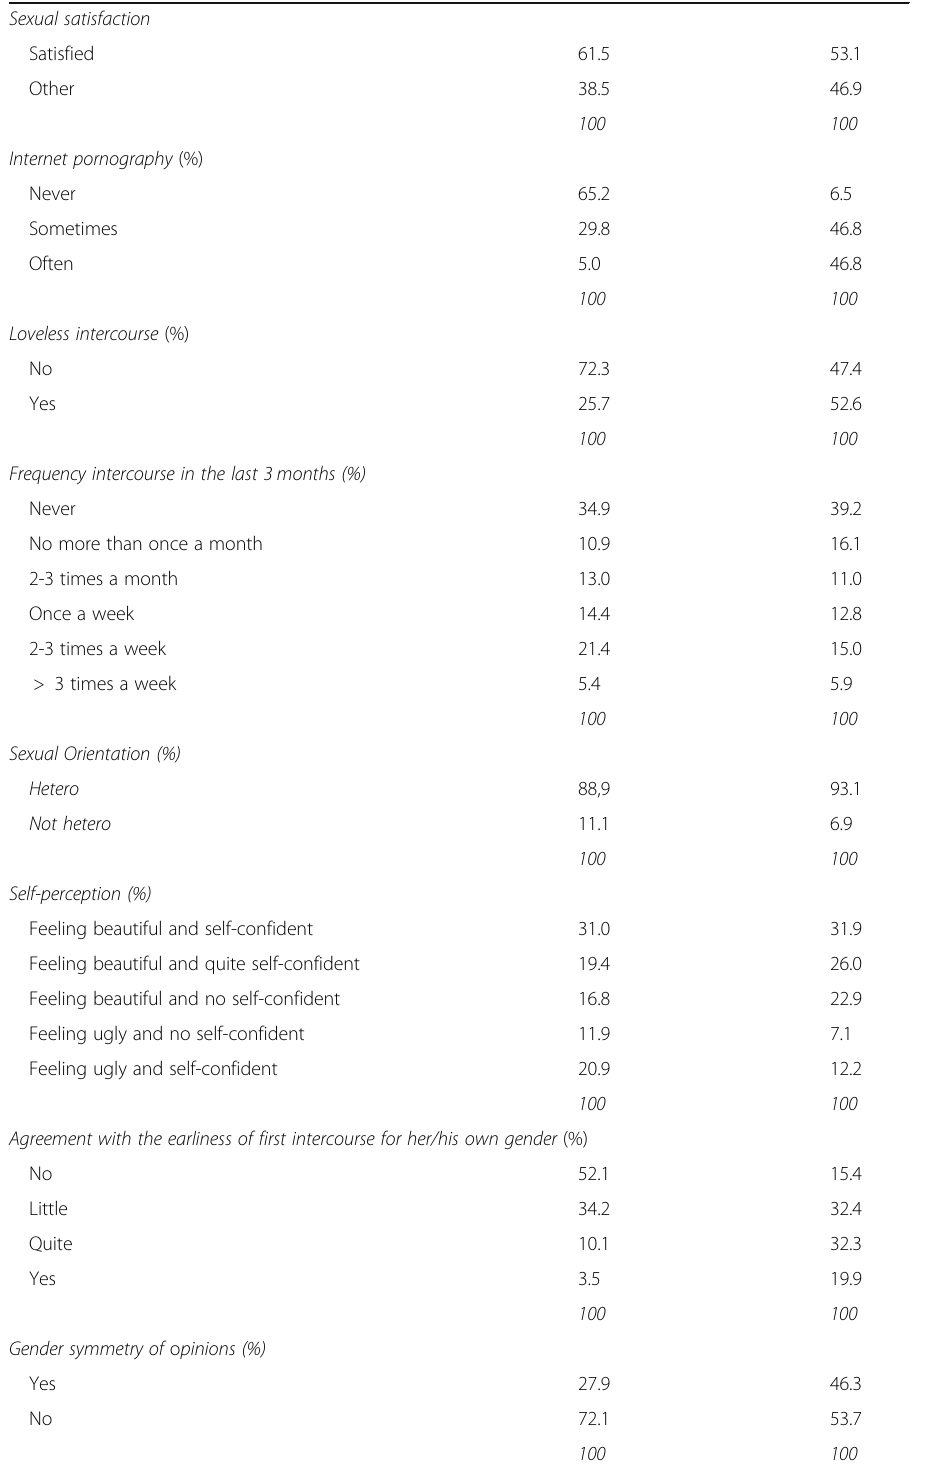
Table 1 Distribution of descriptive statistics among university students, by gender* (SELFY, 2017, weighted